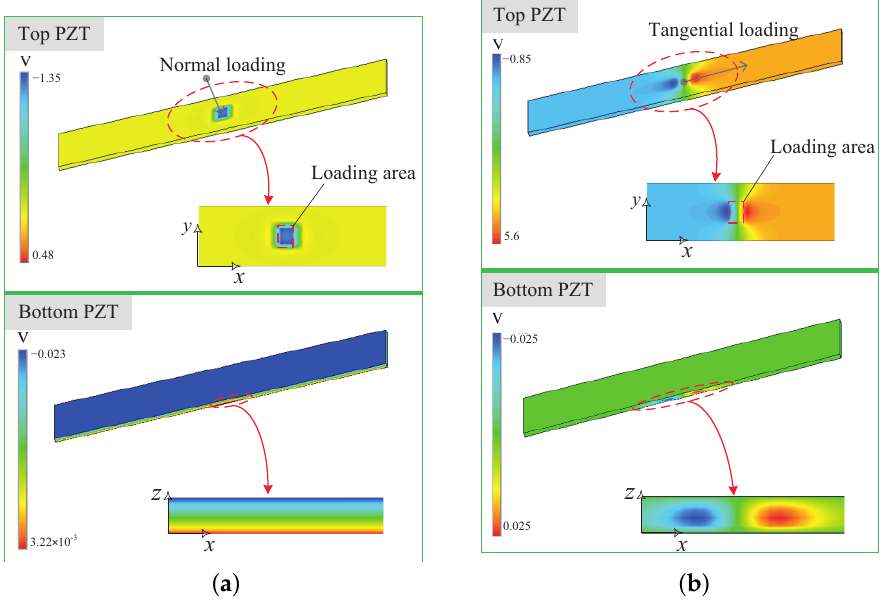
Figure 10. Electric potential distribution of sensor under: ( a ) unit normal force; ( b ) unit tangen- tial